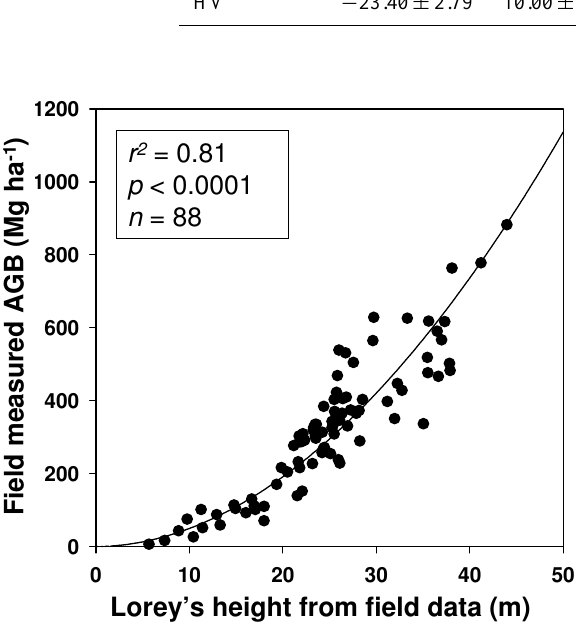
Fig. 5. Field measured AGB for 88 field plots from Lop´e in Gabon, nearby plots in Gabon, and Mbam Djerem National Park in Cameroon, plotted against field-measured Lorey’s height for these plots. This plot dataset is different to that used for the radar-biomass relationship, as the emphasis here was for plots from the same vegetation-type where every stem was measured, to produce an ac- curate regression relationship between Lorey’s height and AGB.